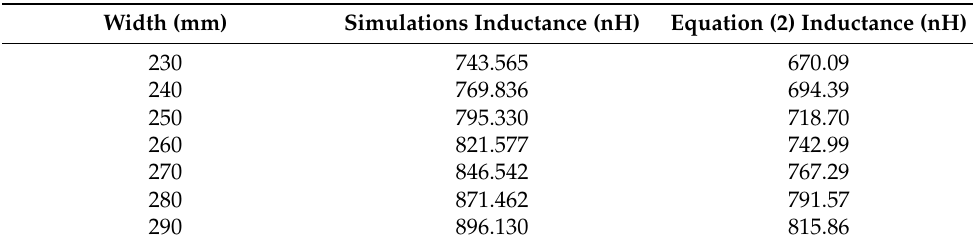
Table 11. Inductance calculation of a single loop rectangle with a constant height (60 mm) using Ansys simulations and Equation (2).